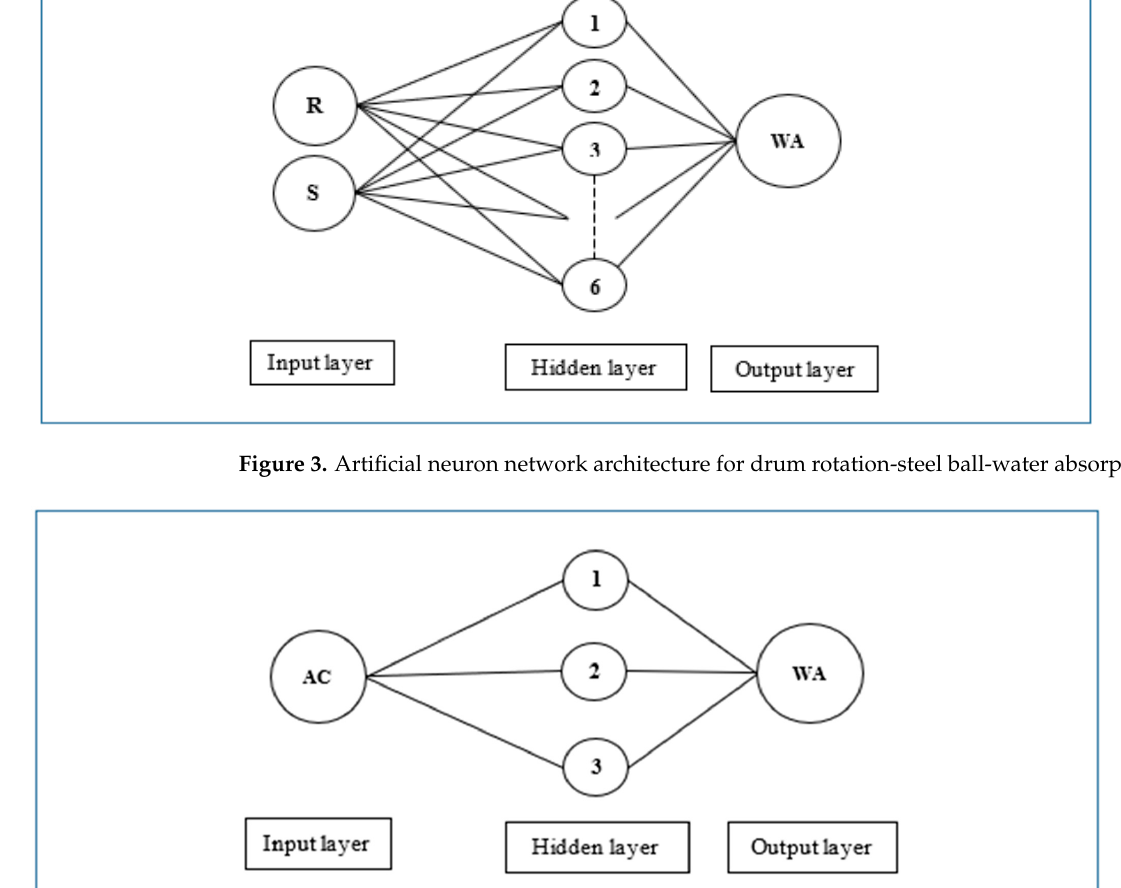
Figure 2. Artificial neuron network model.